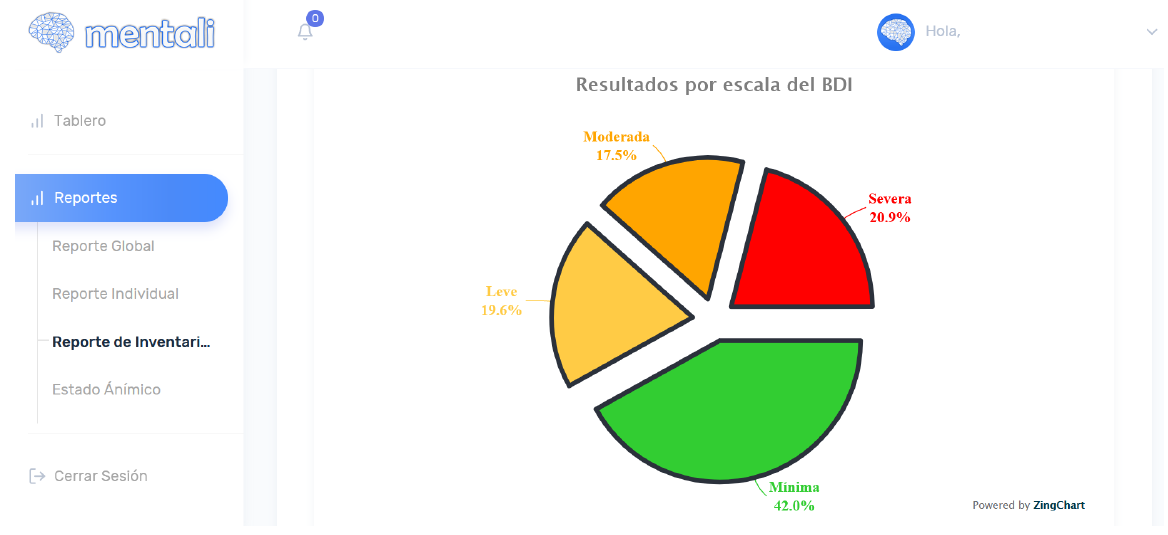
Figure 12. Inventories screen—pie chart.